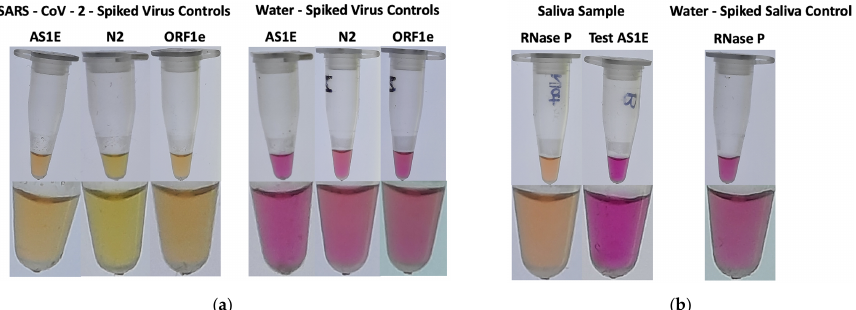
Figure 2. Expected RT-LAMP reaction results. ( a ) Control saliva-sample tubes were mixed 1:1 with a stabilization buffer and nuclease-free water, spiked with 2 µL of heat-inactivated SARS-CoV-2 or with 2 µL nuclease-free water, as indicated, and incubated for 10 min at 95 °C. Four µL of respective mixtures were added to RT-LAMP reactions with SARS-CoV-2 primer sets (AS1E, N2, or ORF1e), and were incubated for 30 min at 65 °C followed by 2 min at 80 °C. Images were taken on a lightbox with 4× (top panel) and 10× (bottom panel) magnification. ( b ) Saliva-sample tubes were mixed 1:1 with a stabilization buffer and saliva or nuclease-free water, as indicated, and incubated for 10 min at 95 °C. RT-LAMP reactions with the RNase P primer set were prepared, and 4 µL of the respective mixtures were added and incubated for 30 min at 65 °C followed by 2 min at 80 °C. Images were taken on a lightbox with 4× (top panel) and 10× (bottom panel) magnification. A negative amplifi- cation of the gene target resulted in the solution to remain pink (basic pH), whereas the target gene amplification results in a color change from pink to yellow (acidic pH).